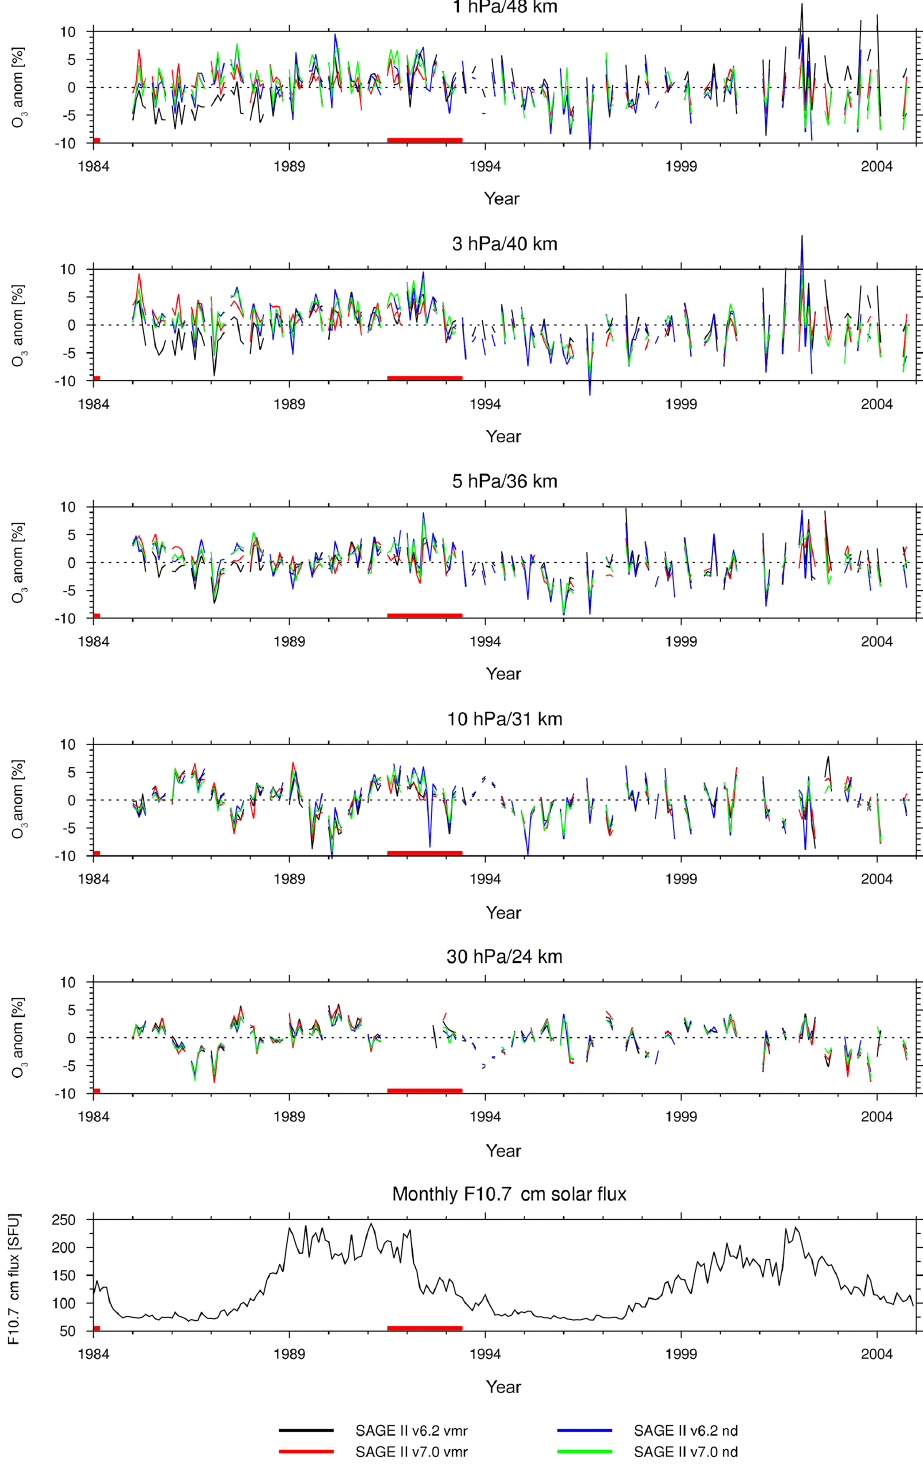
Figure 3. Time series of percent tropical mean (30 ◦ S–30 ◦ N) ozone anomalies for 1984–2004 at (a) 1hPa (48km), (b) 3hPa (40km), (c) 5hPa (36km), (d) 10hPa (31km), and (e) 30hPa (24km). Data are shown for SAGE II v6.2 volume mixing ratios (vmr) (black), SAGE II v7.0 vmr (red), SAGE II v6.2 number densities (nd) (blue), and SAGE II v7.0 nd (green). The thick red lines denote the periods excluded from the MLR analysis following major tropical volcanic eruptions. The bottom panel shows the F10.7cm solar flux for reference.